Question: Name the type of graph shown.
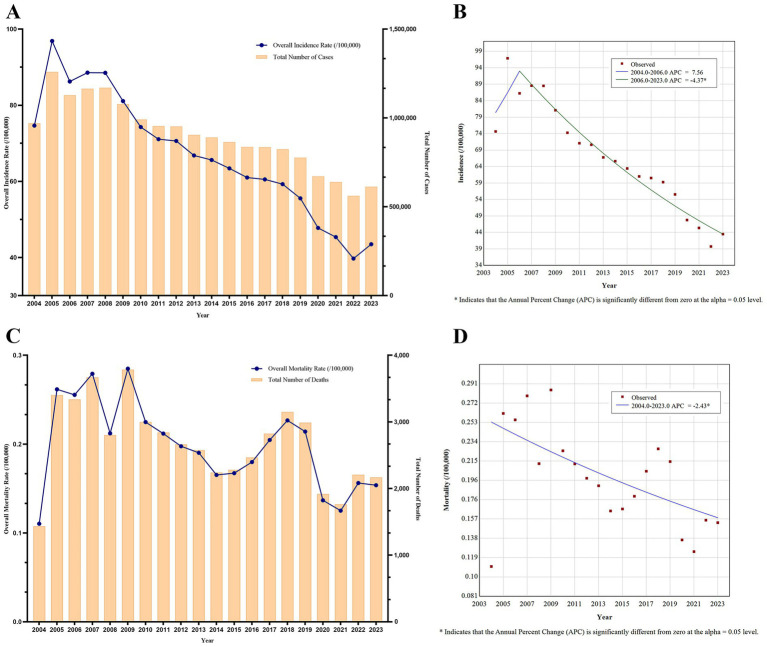
Answer: line